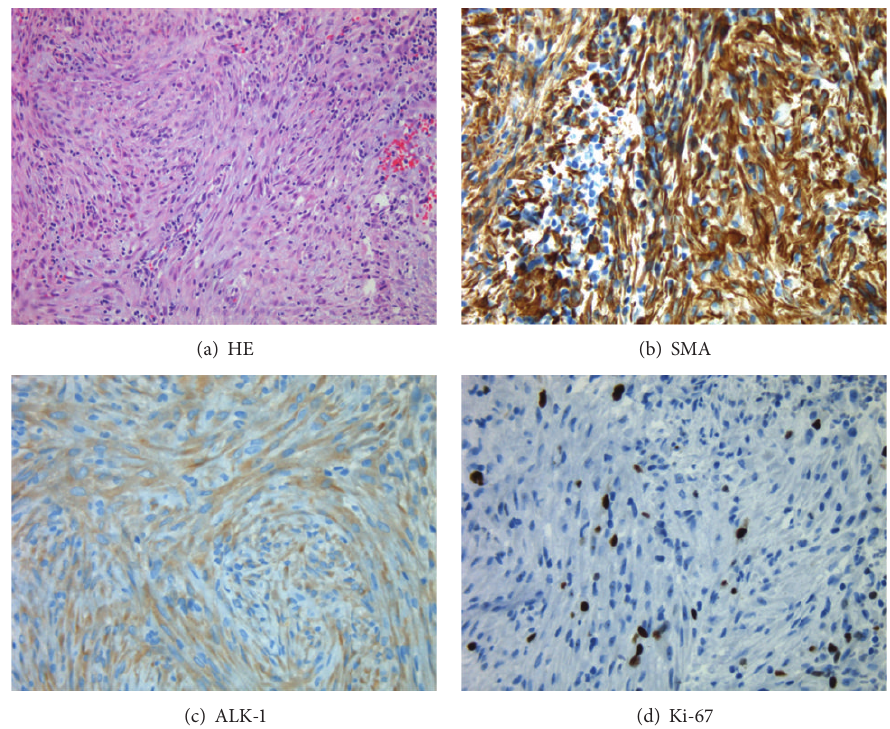
Figure 3: (a) Hematoxylin-eosin staining showed dense aggregates of spindle cells in storiform architecture with scattered lymphocytes. (b) Immunohistochemical staining is strongly positive with smooth muscle actin and (c) with ALK (d) while Ki-67 positivity was low.